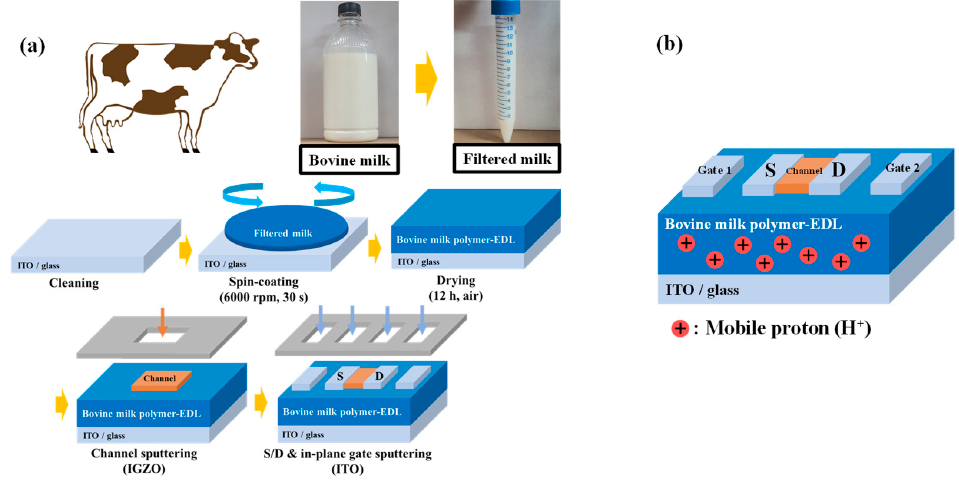
Figure 1. ( a ) Fabrication process and ( b ) structure of bovine-milk-polymer-based synaptic transis- tors.